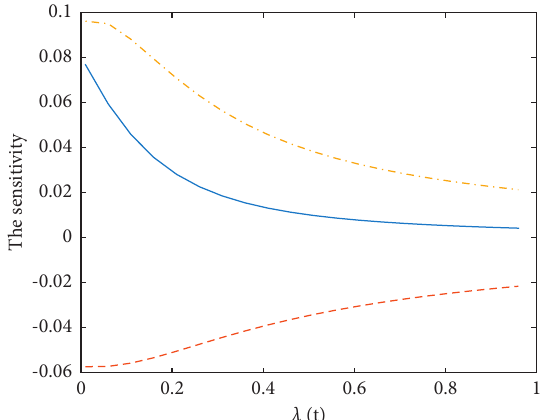
Figure 6: The sensitivity of jump intensity on CDS prices under the Vasicek model with